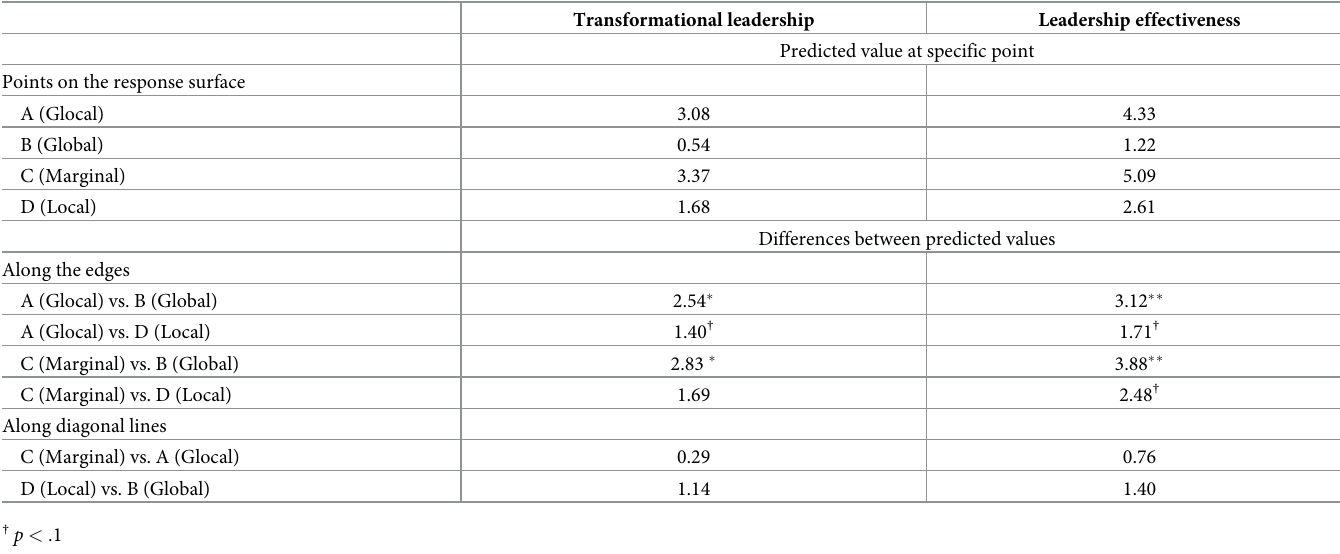
Table 3. Testing the equality between predicted values on the response surfaces.